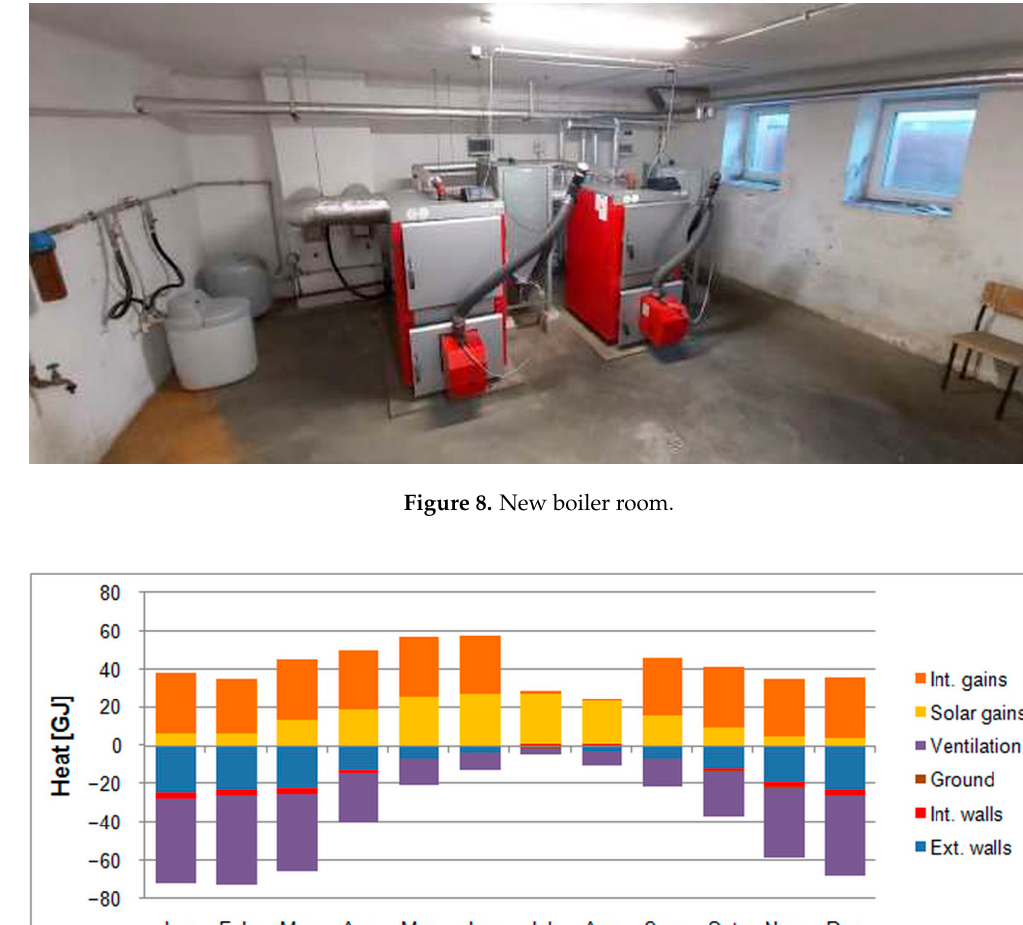
Table 5. Effectiveness of the modernization. Quantity